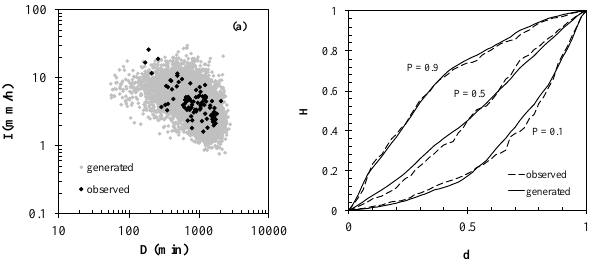
Figure 5. Duration–intensity correlation (left) and adimensional shapes